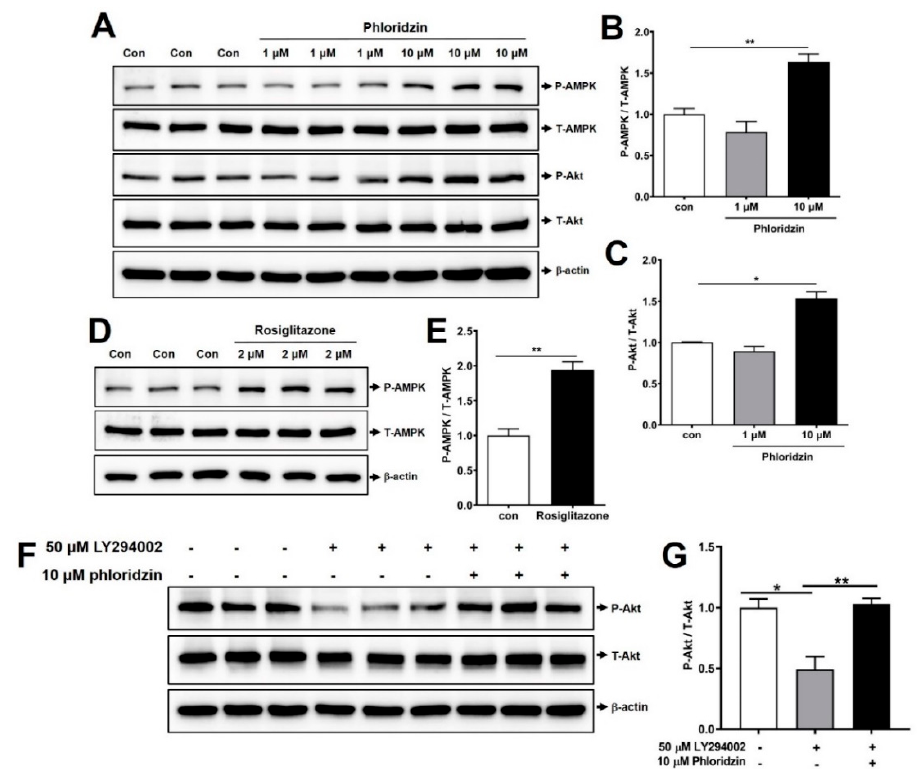
Figure 5. Phloridzin enhances the phosphorylation of AMPK and Akt. ( A , D ) Mature adipocytes were incubated with 1 or 10 µ M phloridzin or 2 µ M rosiglitazone. After 72 h, the cells were lysed, and Western blotting was performed using antibodies against phosphorylated AMPK, total AMPK, phosphorylated Akt, total Akt, and beta-actin. ( B , C , E , G ) Quantification of phospho-AMPK/total-AMPK ( B , E ) and phospho-Akt/total-Akt ( C , G ) using the ATTO image analysis software (CS analyzer 4). ( F ) 50 µ M LY294002 or 10 µ M phloridzin were treated in mature 3T3-L1 adipocytes. After 24 h, cells were lysed and analyzed by Western blotting. All experiments were independently repeated at 3 times. Results are presented as mean ± SEM. Data were analyzed using two-tailed unpaired t -test. ** p < 0.01, * p < 0.05 compared to the control